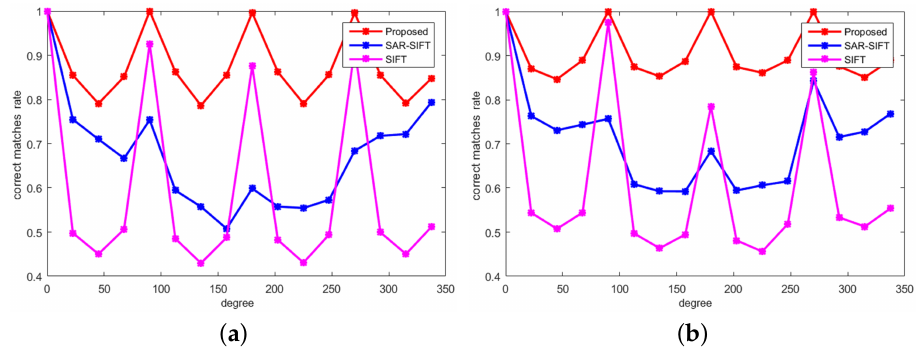
Figure 6. The curves of Correct Matches Rate (CMR) versus angles. ( a ) the GF-3 image; ( b ) the TerraSAR-X